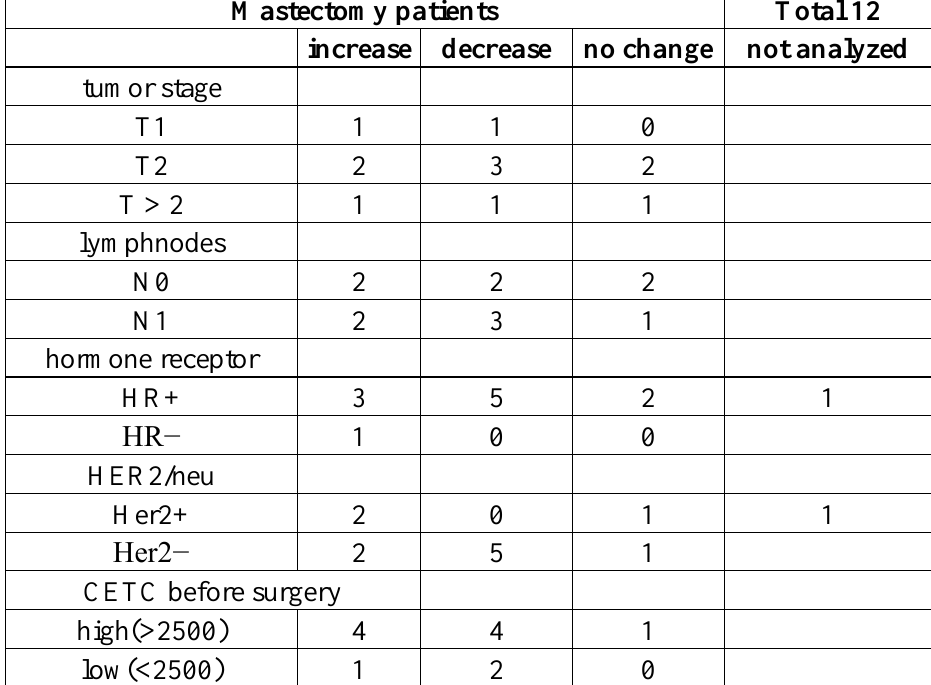
Table 2. Tumor characteristics of patients with increasing, decreasing and no change in CETC after treatment with